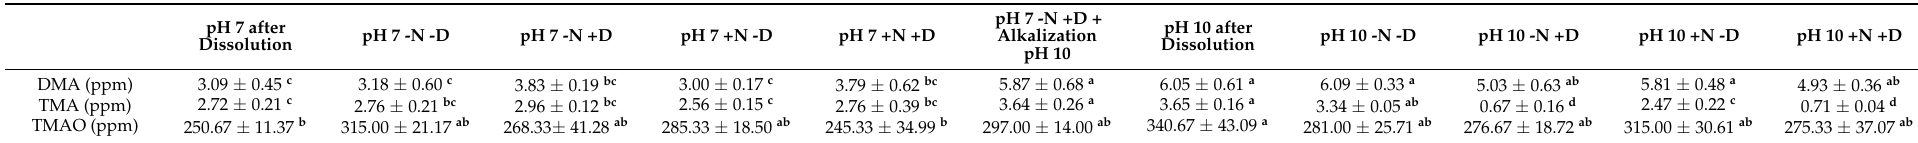
Table 1. Dimethylamine (DMA), Trimethylamine (TMA) and Trimethylamine Oxide (TMAO) contents of Herring Milt Hydrolysate (HMH) after dissolution and after the different treatments (mean ± standard deviation).